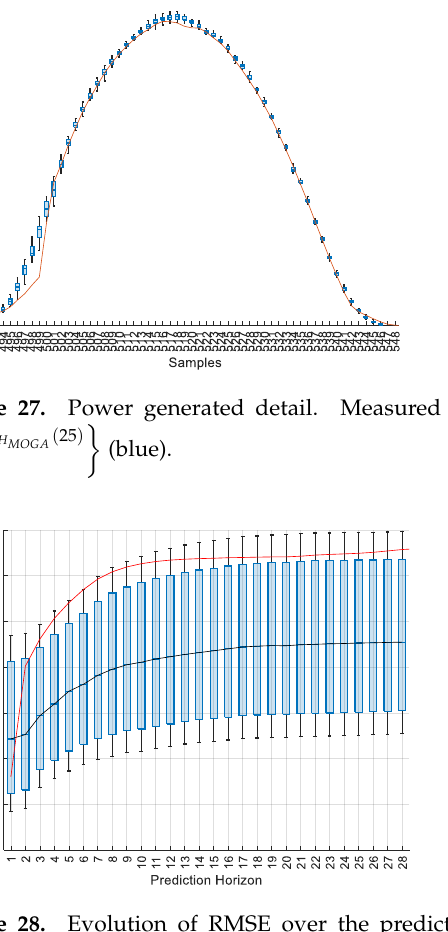
models. As observed, the